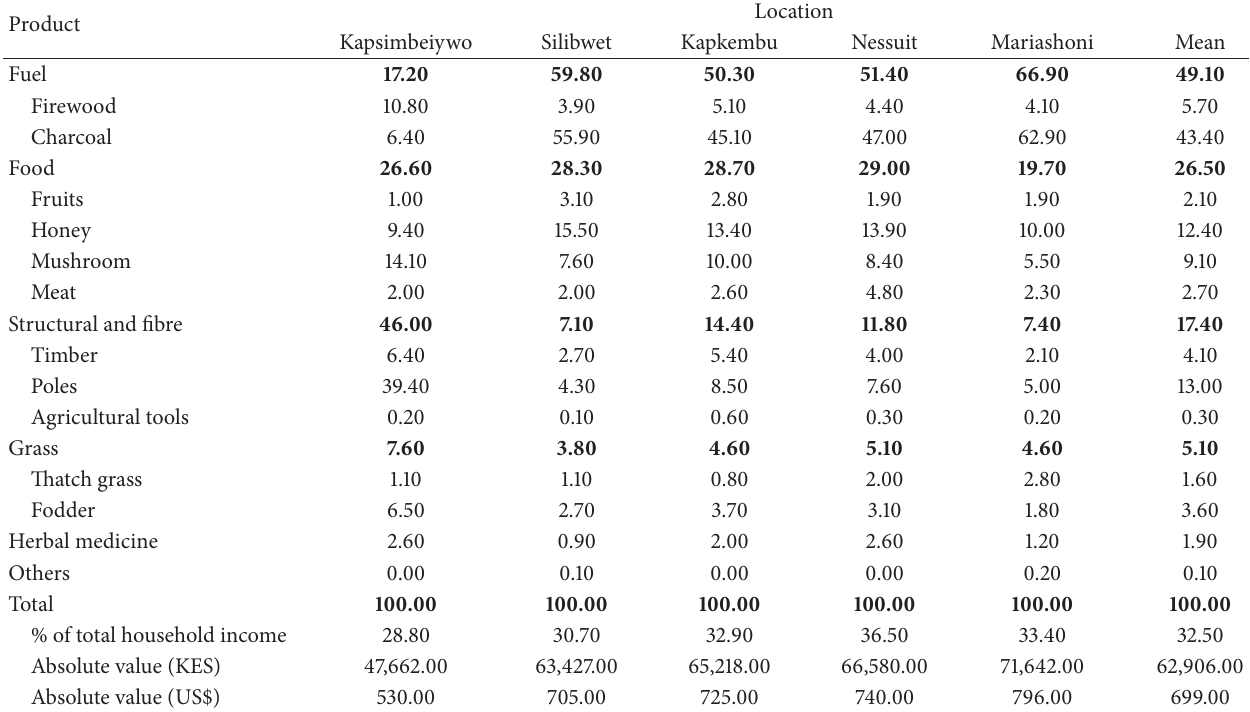
Table 4: Contribution of forest products category to forest